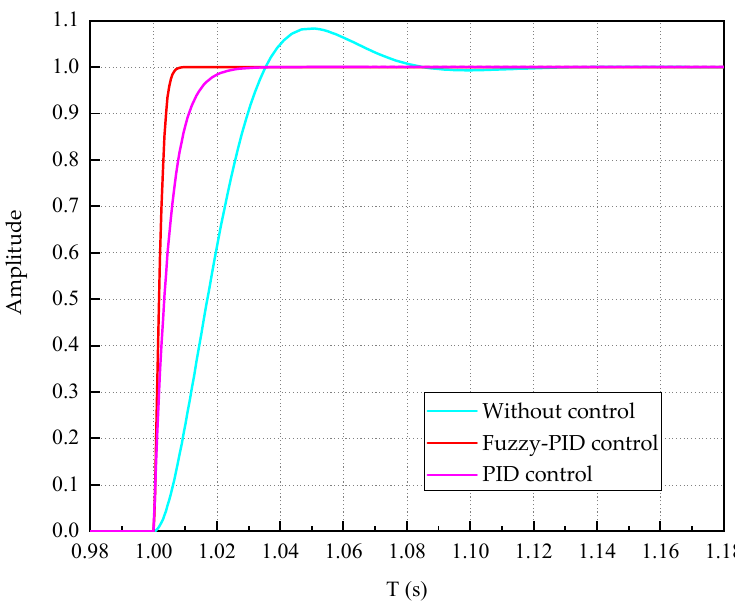
Figure 11. Unit step response curve of the braking system.